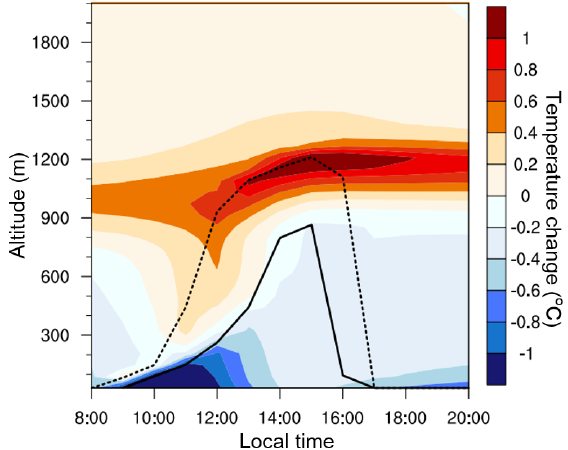
Figure 2. Diurnal variations of the air temperature change caused by aerosols during haze episodes in Beijing and of PBL height for simulation scenarios with (solid line) and without (dashed line)